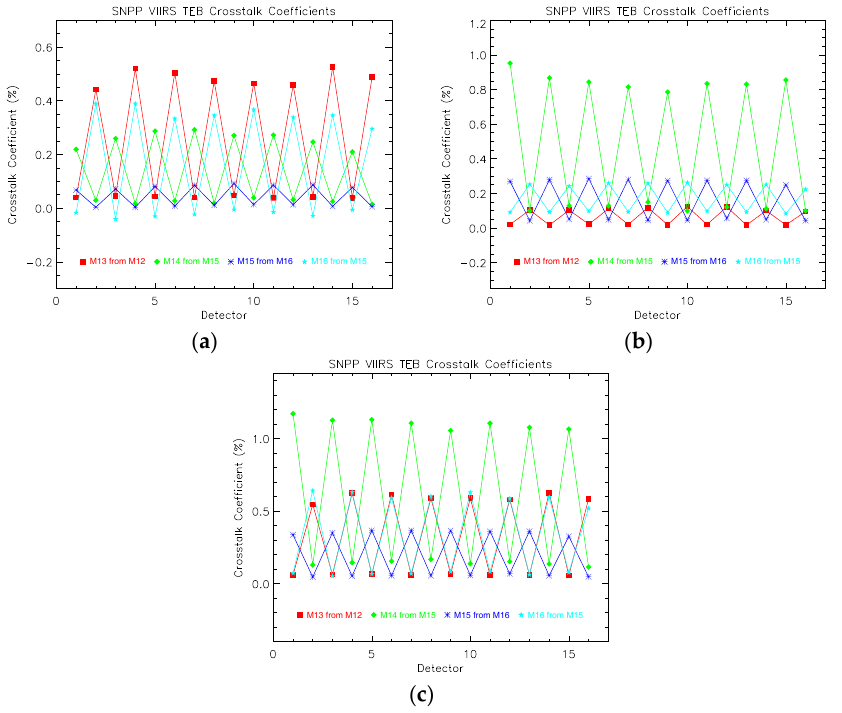
Figure 11. Crosstalk coefficients for SNPP VIIRS Bands M13–M16: ( a ) from odd detectors of the corresponding sending band, ( b ) from even detectors of the corresponding sending band, and ( c ) from all detectors of the corresponding sending band.